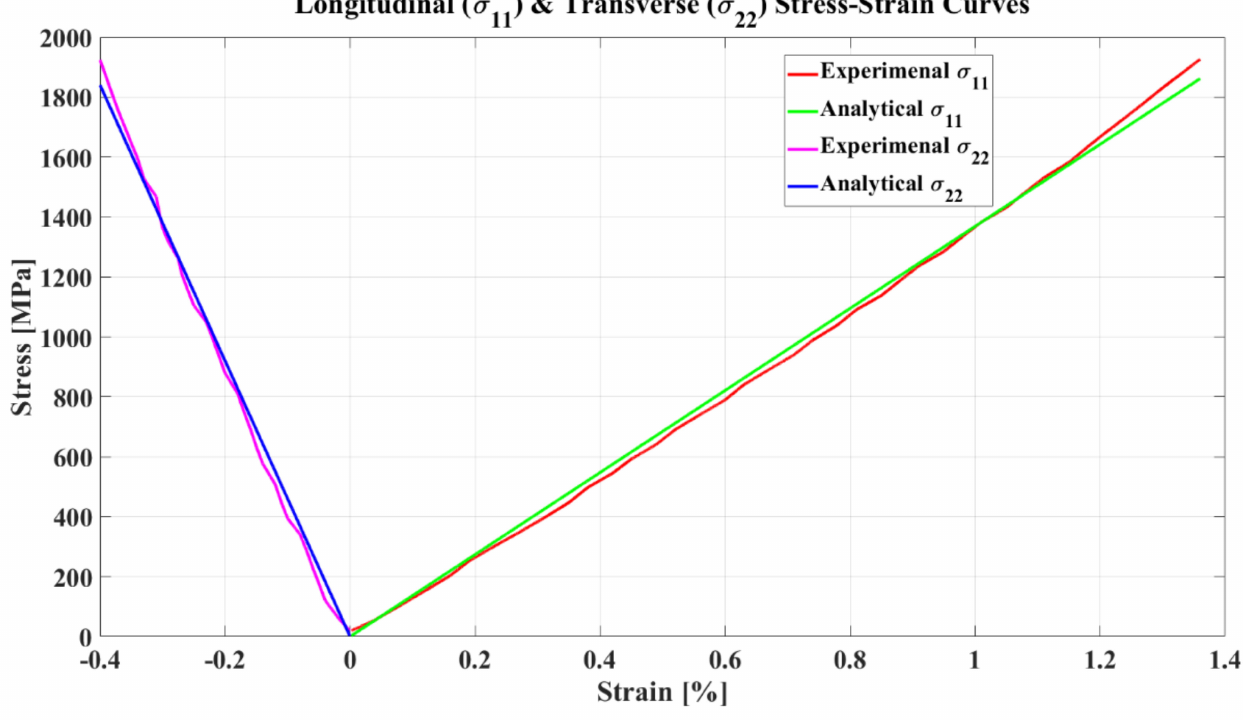
Figure 9. Comparisons between the experimentally measured and analytically predicted by optimal model of longitudinal σ 11 and transverse σ 22 stress–strain curves for uniaxial loading.